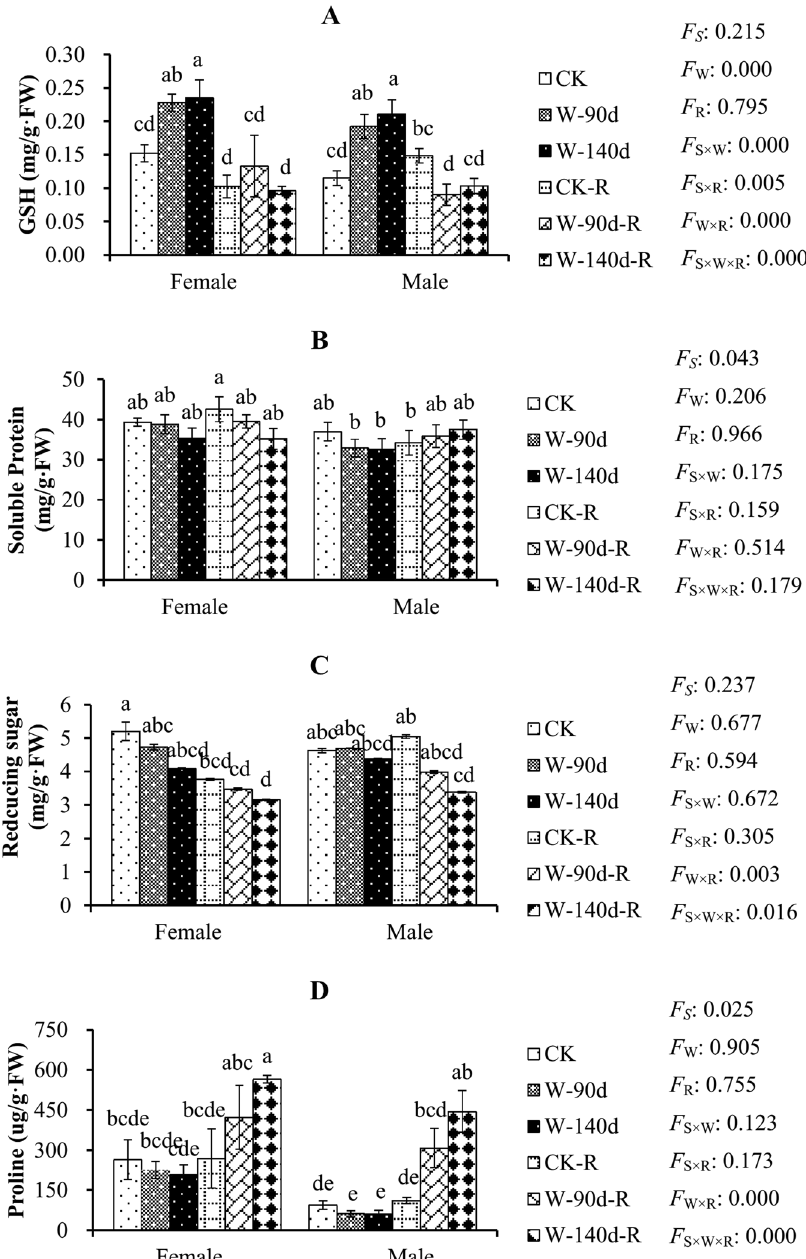
Figure 4. Glutathione (GSH), soluble protein, reducing sugar and free proline content variations in male and female P. deltoides under winter flooding stress and post-flooding recovery. CK, control treatment; W, flooding and waterlogging stress treatment; R, recovery after waterlogging stress. Values are means ± SE ( n = 5). Letters above the columns indicate significantly differences at P < 0.05 according to Duncan’s test. The significance values of the factorial analysis (ANOVA) for: F S , F W , and F R refer different effects of species, watering, and recovery growth, respectively; F S × W , F S × R , F W × R , and F S × W × R refer species × watering effects, species × recovery growth effects, watering × recovery growth effects, and species × watering × recovery growth effects,